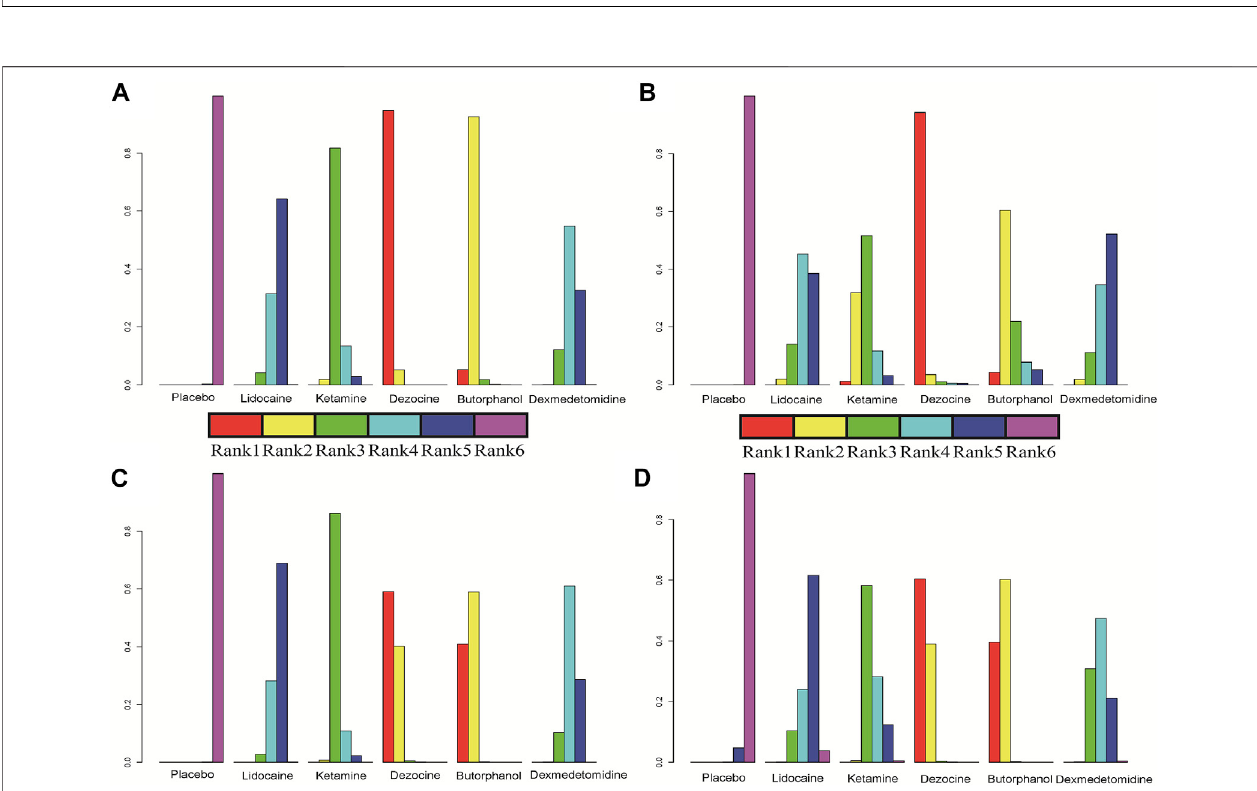
FIGURE5| Individualrankplotforfourclinicaloutcomes. (A) IncidenceofOIC; (B) MildseverityofOIC; (C) ModerateseverityofOIC;and (D) SevereseverityofOIC.